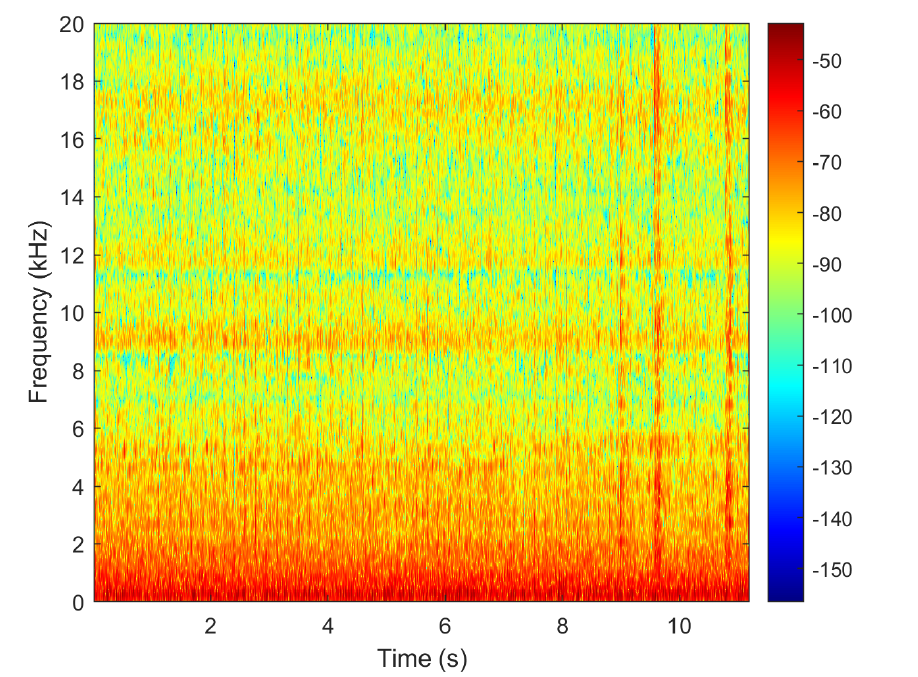
Figure 6. Time-frequency representation of the signal with impulsive disturbance.